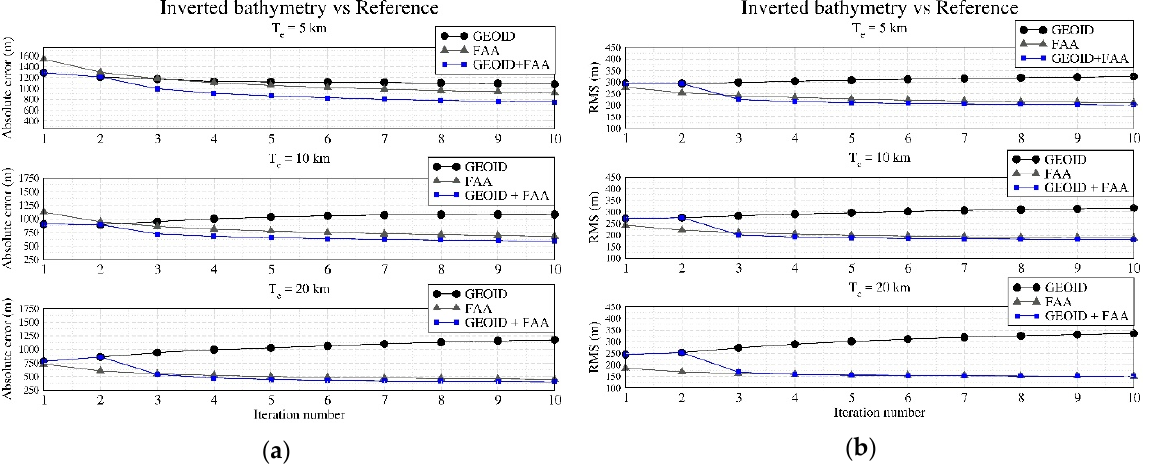
Figure 8. Convergence of the inversion, ( a ) Absolute error and ( b ) RMS, of noisy geoid heights (GEOID), free-air anom- alies (FAA) and their combination (GEOID + FAA) using EKF and including compensation effects for T e equal to 5 km, 10 km and 20